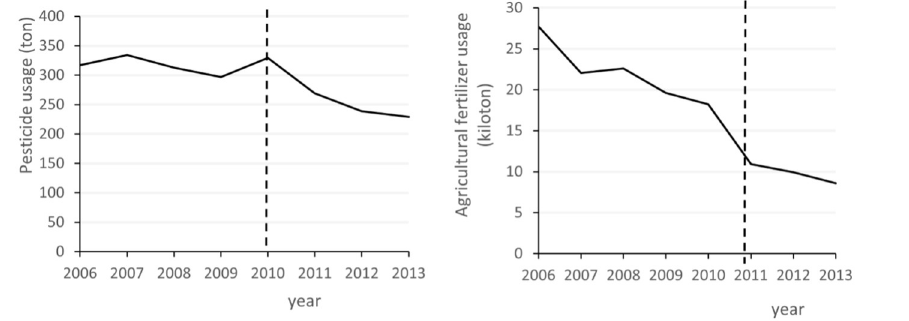
Fig 13. Pesticide and fertilizer consumptions in